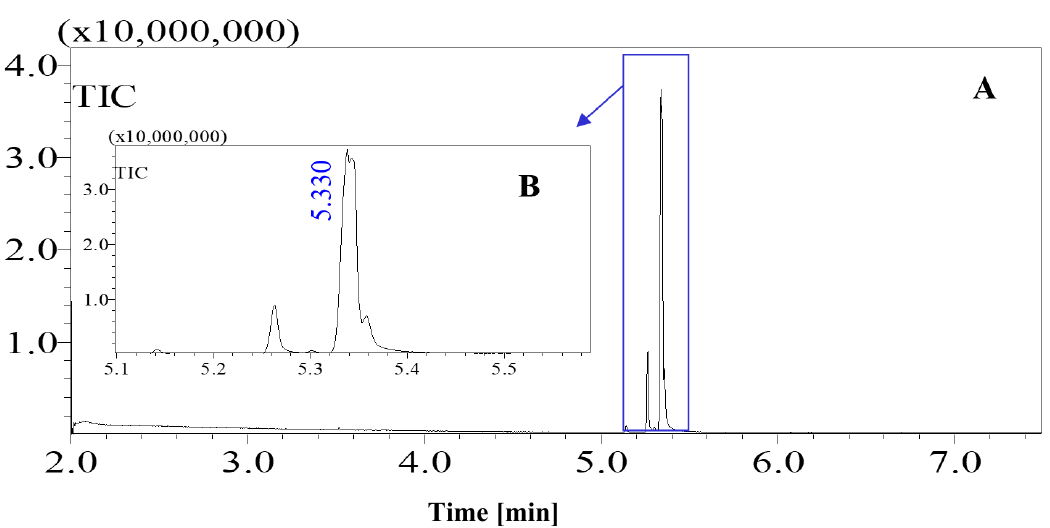
Figure 3. Total ion chromatogram (TIC) of standard D -glucose. Chromatograph of the oximated and silylated glucose sample was obtained. Glucose syn and anti-forms were observed at 3.95 and 3.99 min. ( A ) Total chromatogram of a standard glucose sample for a 7-min measurement; ( B ) the glucose standard sample from 3.9–4.1 min.